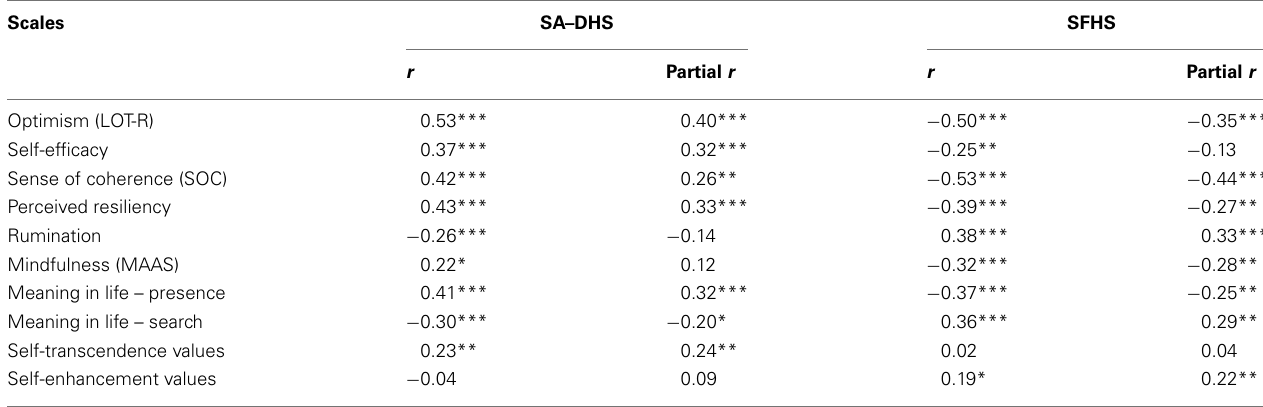
Table 4 | Correlations of the SubjectiveAuthentic–Durable Happiness Scale and the Subjective Fluctuating Happiness Scale with various convergent measures (samples D and E).